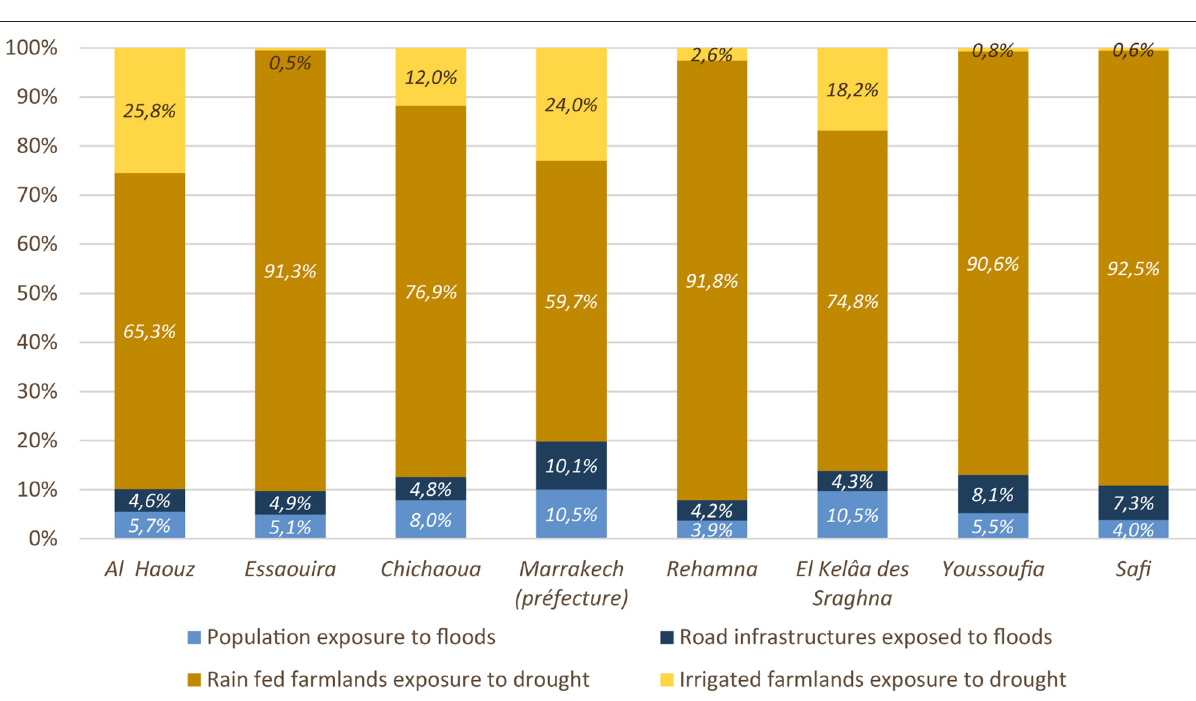
FIGURE 5 | Average contribution (%) per province of single-risks hazard exposure scores to overall multi-risk hazard exposure